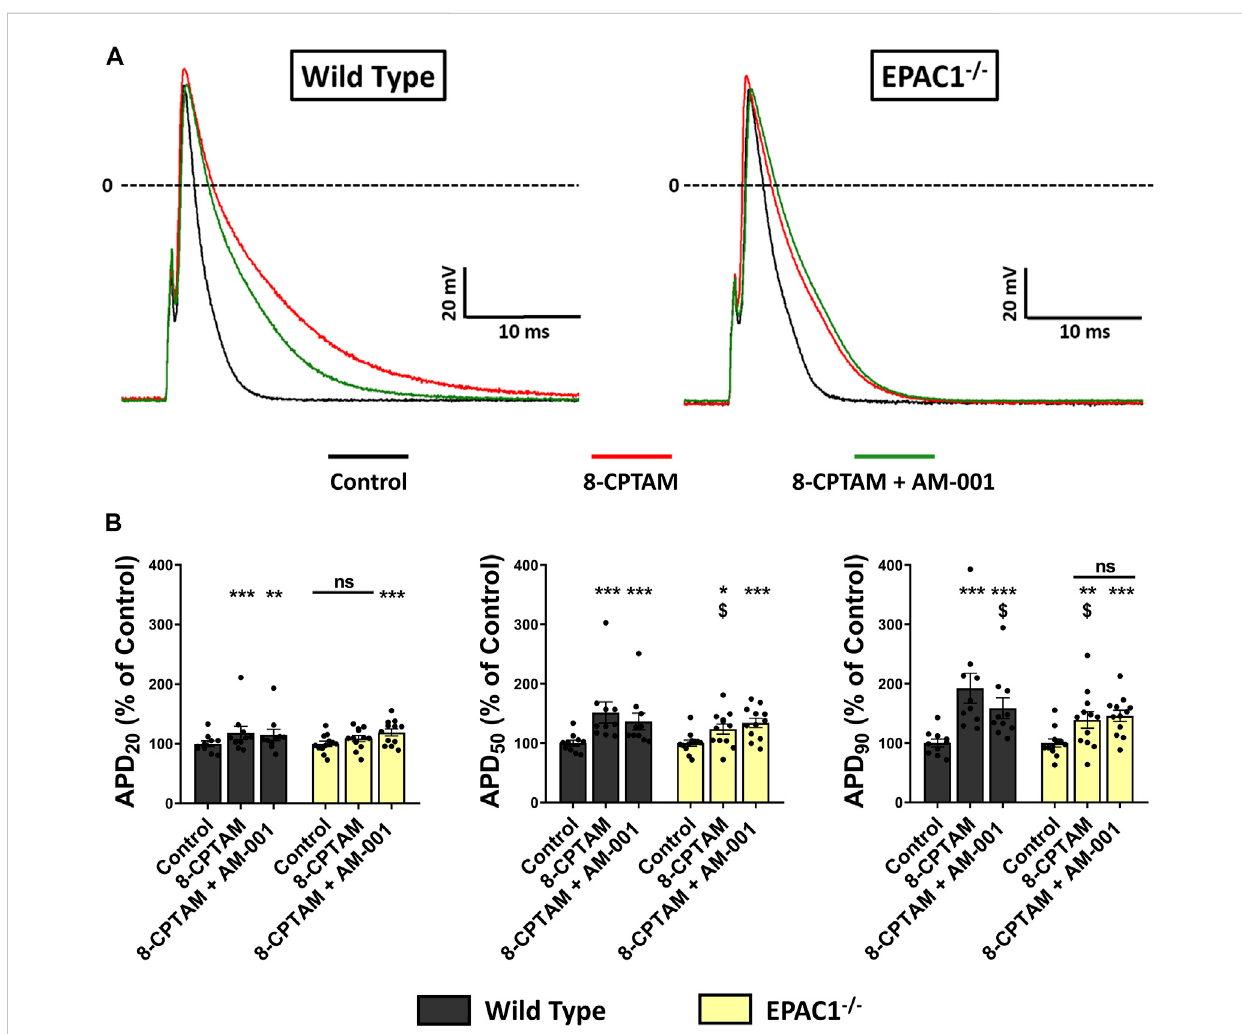
FIGURE 6 EffectofpharmacologicalEPACactivationandselectiveEPAC1inhibitioninAPDonWTandEPAC1deletedatrialmyocytes. (A) Representativetraces ofAPinresponsetoEPACactivationandEPAC1selectiveinhibition. (B) Mean±SEMofAPD20,APD50andAPD90,relativetocontrol( n =10, N =5forWT and n =12, N =6forEPAC1 − / − ).Ateachpercentageofrepolarization,EPACactivationby8-CPT-AM(10 μ mol/L)increasesAPDonWTmyocytes,andthis effectispartiallycorrectedbyEPAC1selectiveinhibition.InEPAC1 − / − myocytes,effectof8-CPT-AMisreducedcomparedtoWTandnotcorrected by AM-001 treatment. Statistical differences were determined by two-way repeated measure ANOVA with Holm-Sidak post hoc test and Friedman ’ s ANOVAonrankswithDunn ’ smultiplecomparisonspost-hoc. * p < 0.05vs.control,** p < 0.01 vs.control,*** p < 0.001 vs.control.$isfor p < 0.05vs.WT 8-CPTAM